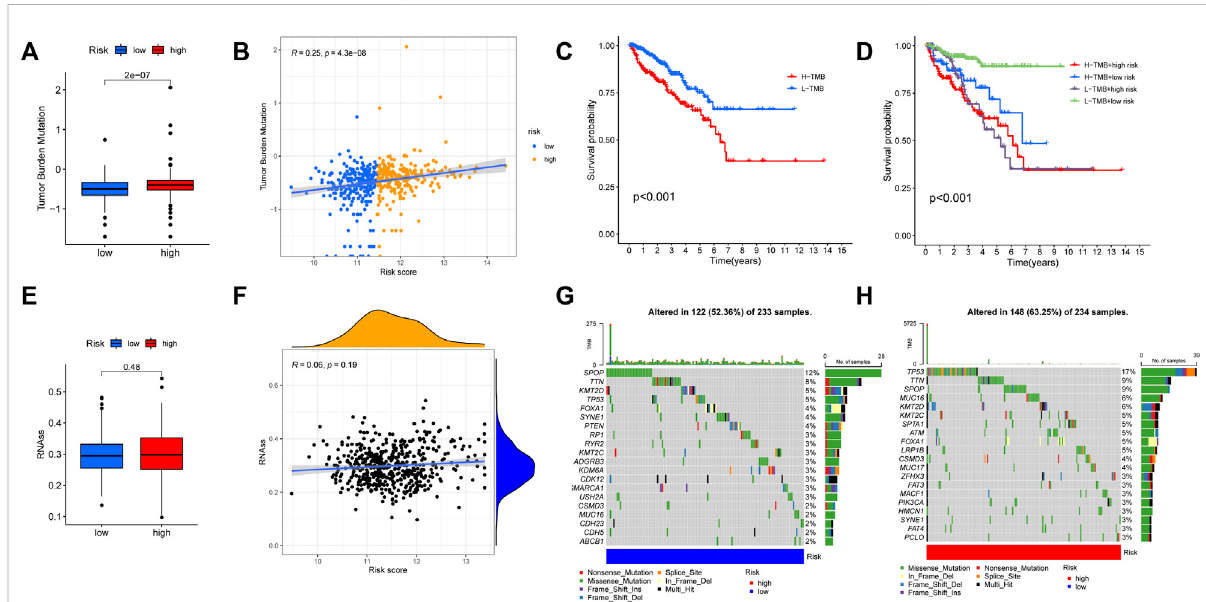
FIGURE 12 Comparison of tumor mutation burden (TMB) between high and low risk groups. (A) The TMB score was different between high and low risk groups. (B) The risk score was signi fi cantly and positively correlated with TMB. (C) The KM curves for patients with high and low TMB. (D) The KM curves showed that the L-TMB + low-risk group had the best prognosis. (E,F) No signi fi cant relationship was found between the risk score and mRNAsi. (G) The tumor somatic mutation of patients in the low-risk group. (H) The tumor somatic mutation of patients in the high-risk group.